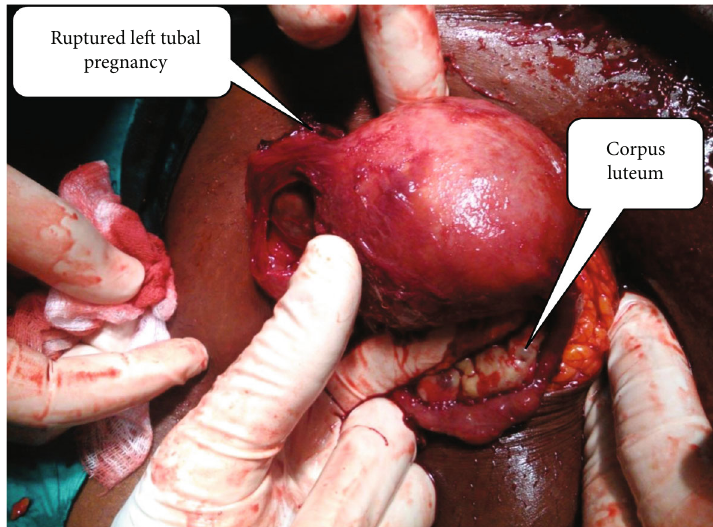
Figure 2: Intraoperative fi ndings: ruptured left tubal pregnancy and contralateral corpus